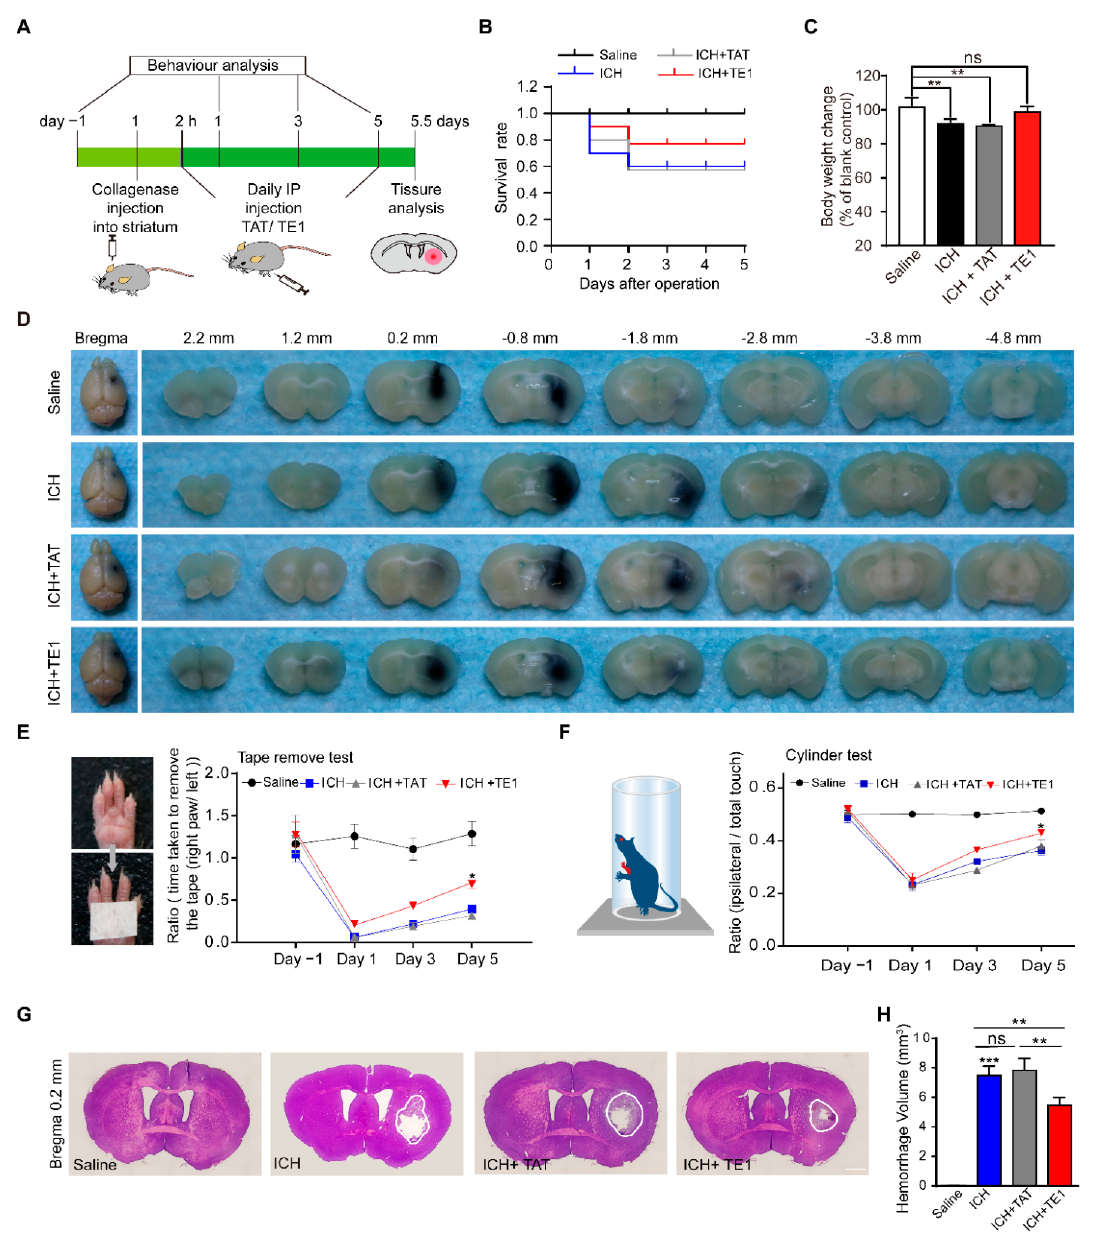
Figure 5. Netrin-1 derived peptide E1 promotes recovery process after ICH. ( A ) Schematic of the experimental paradigm of intraperitoneal (IP) injection of peptide TE1 in ICH modeling of mice. ( B ) Survival ratio post-ICH of each group was recorded, the Kaplan-Meier method was employed. n = 10. ( C ) Body weight changes at 5 days after ICH. n = 6. ( D ) Collage/Saline mix with equal ratio of ink (total 0.6 µ L) injected in striatum of C57 mice, representative images showing ink area were similar in mice treat with/without peptide TE1 5 days after ICH. ( E , F ) IP injection of peptide TE1 (12 mg/kg) but not TAT (12 mg/kg) control, improved behavior as monitored by a tape removal task ( E ) or a corner task ( F ). Saline, n = 10 individual animals; ICH, n = 6 individual animals; ICH + TAT, n = 6 individual animals; ICH + TE1, n = 8 individual animals. ( G ) Representative hematoxylin and eosin-stained sections in mice treat with/without peptide TE1 5 days after ICH. Scale bar, 1 mm. ( H ) Quantitation of hemorrhage volume in brain sections shown in ( G ). Saline, n = 10 individual animals; ICH, n = 6 individual animals; ICH + TAT, n = 6 individual animals; ICH + TE1, n = 8 individual animals. Data are presented as the means ± SEM. One-way ANOVA or Two-way ANOVA was used for all statistical analyses shown in this figure (* p < 0.05, ** p < 0.01, *** p < 0.001; ns, not significant). Details of data analysis are seen in Supplementary Table